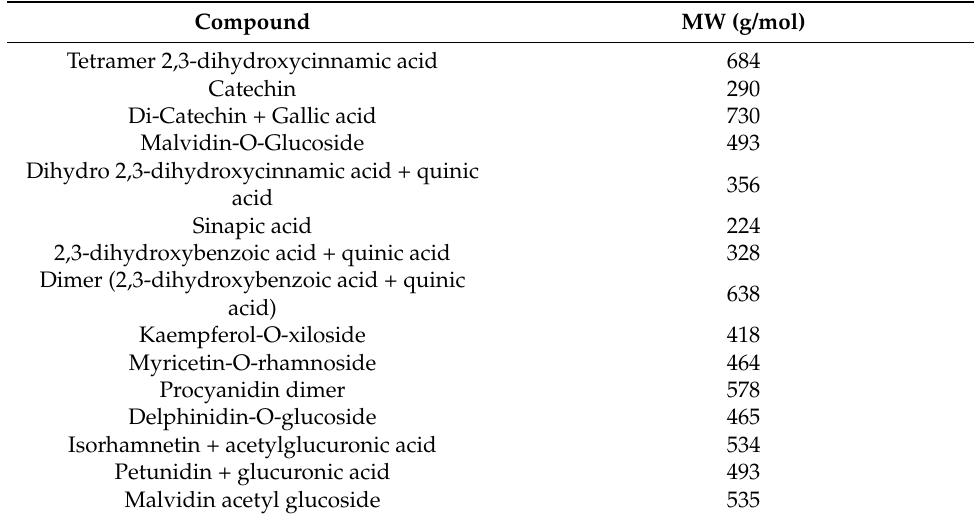
Table 6. List of principal compounds obtained from the grape skin extraction with ethanol 70% ( v/v ) and 90 ◦ C and their mass spectrometric